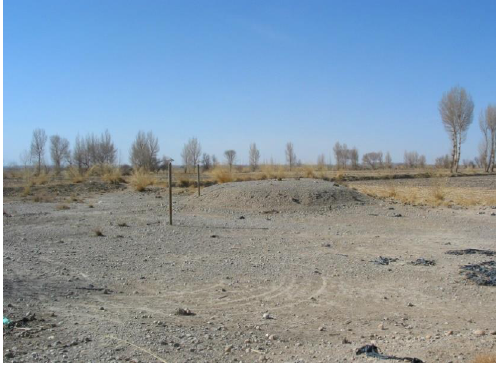
Figure 3. Tomb mound, gravel and sand, Jiuquan, Wei-Jin period, 220–317 CE.